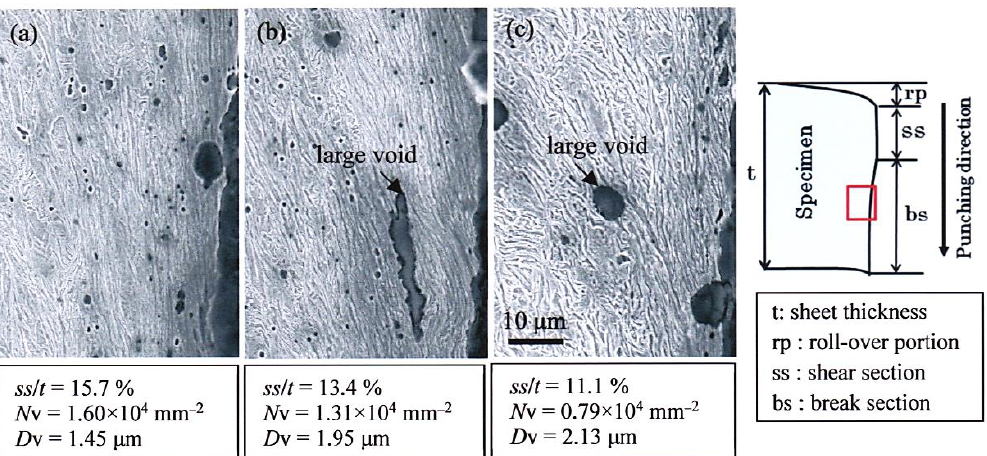
Figure 11. SEM images of break section after hole punching of ( a ) the 1.5Mn, ( b ) 3Mn, and ( c ) 5Mn steels subjected to the IT process at T IT = 370 ◦ C, 280 ◦ C, and 180 ◦ C, respectively. The IT temperatures are corresponding to M f + (30 ◦ C to 70 ◦ C). ss / t : a ratio of shear section length ( ss ) to thickness ( t ), N v : void density, D v : average void diameter.